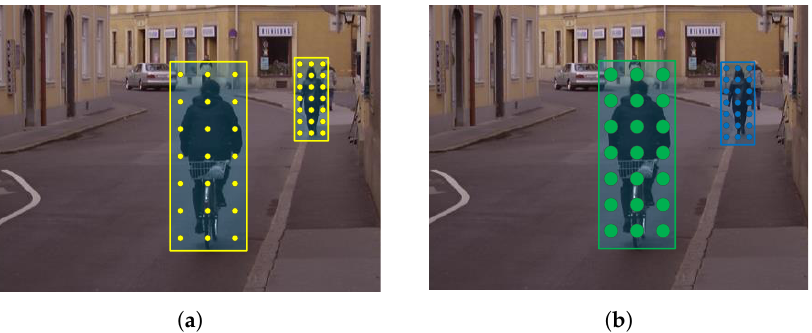
Figure 2. Illustration of the problem of receptive field correspondence in MRFC method. ( a ) The yellow circles represent the receptive fields of a feature. Note for pedestrians of different scales, the area of the circle do not change, which is unreasonable; ( b ) The ideal circumstance is the receptive field of a feature resizes according to the scale of the pedestrian. Note the areas are different for circles of different